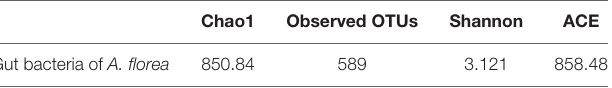
The taxonomic assignment was performed using SILVA